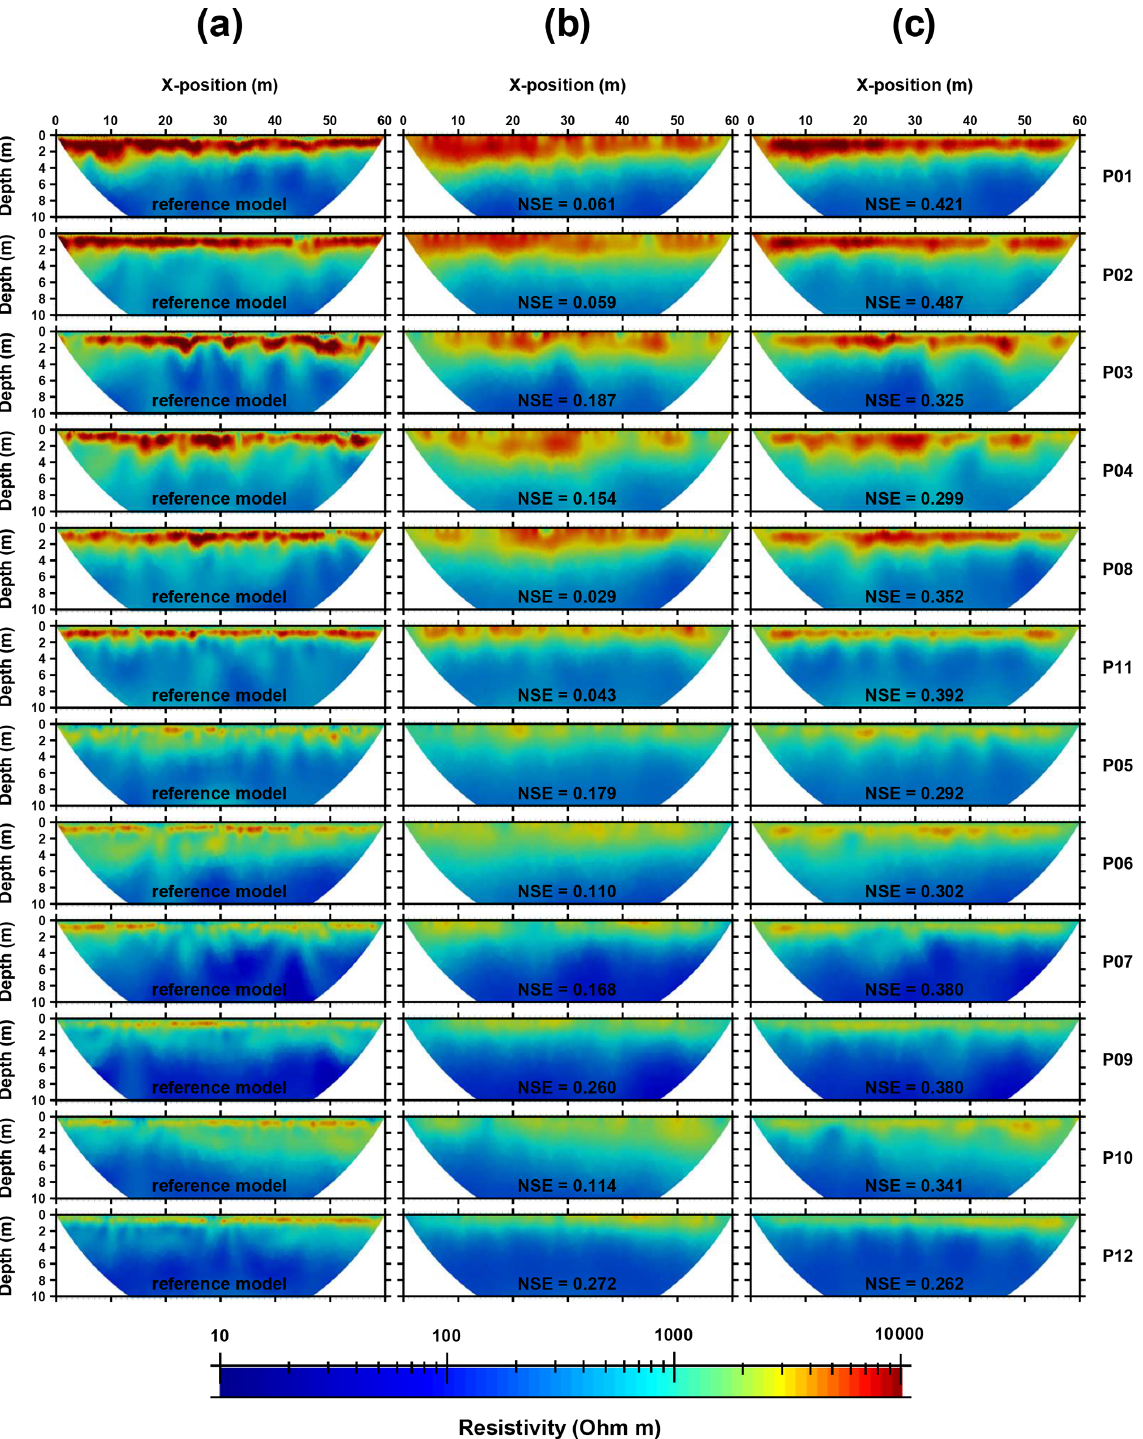
Figure 8. Inversion results obtained for the 12 plot-scale ERT profiles measured in the Weierbach catchment using an ES of 0.5m (a) or 2m without (b) or with the four interpolated levels of surficial apparent resistivity (c) . Nash–Sutcliffe model efficiency (NSE) values were added to each ERT image relying on an ES of 2m using ERT images obtained with an ES of 0.5m as